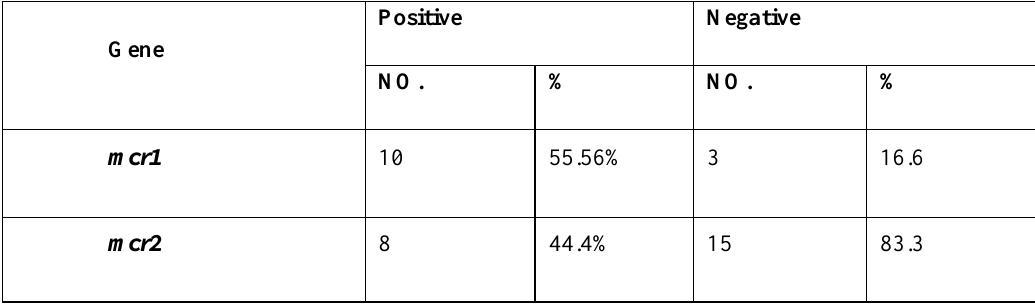
Table 8. Distribution of mcr1 and mcr2 genes in colistin-resistant P. aeruginosa isolates.